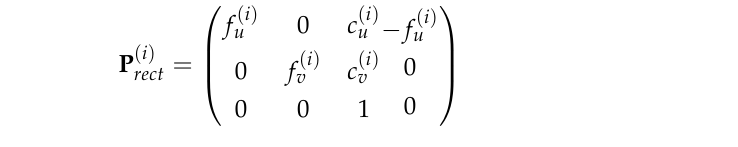
( b ) Figure 4. Visualization of annotated ground truth: The first row is the annotated 2D ground truth, and the second row is the projection of the annotated 3D ground truth onto the image. ( a ) Field scene; ( b ) Agricultural road scene. ( a ) shows the ground truth of obstacle labeling in the field scene, while ( b ) shows the ground truth of obstacle labeling in the agricultural road scene.